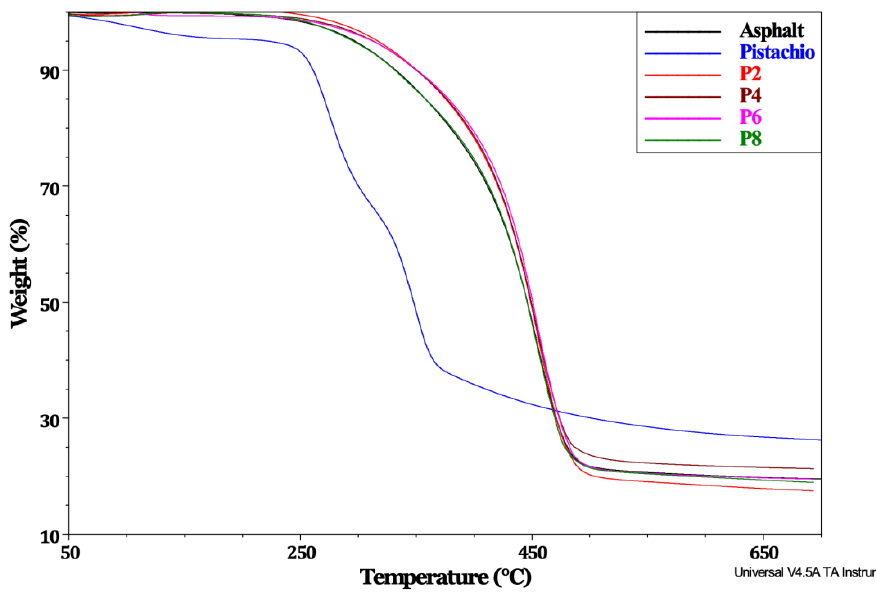
Figure 8. TGA thermograms of asphalt, pistachio shells and modified asphalt mix with pistachio seed shells.